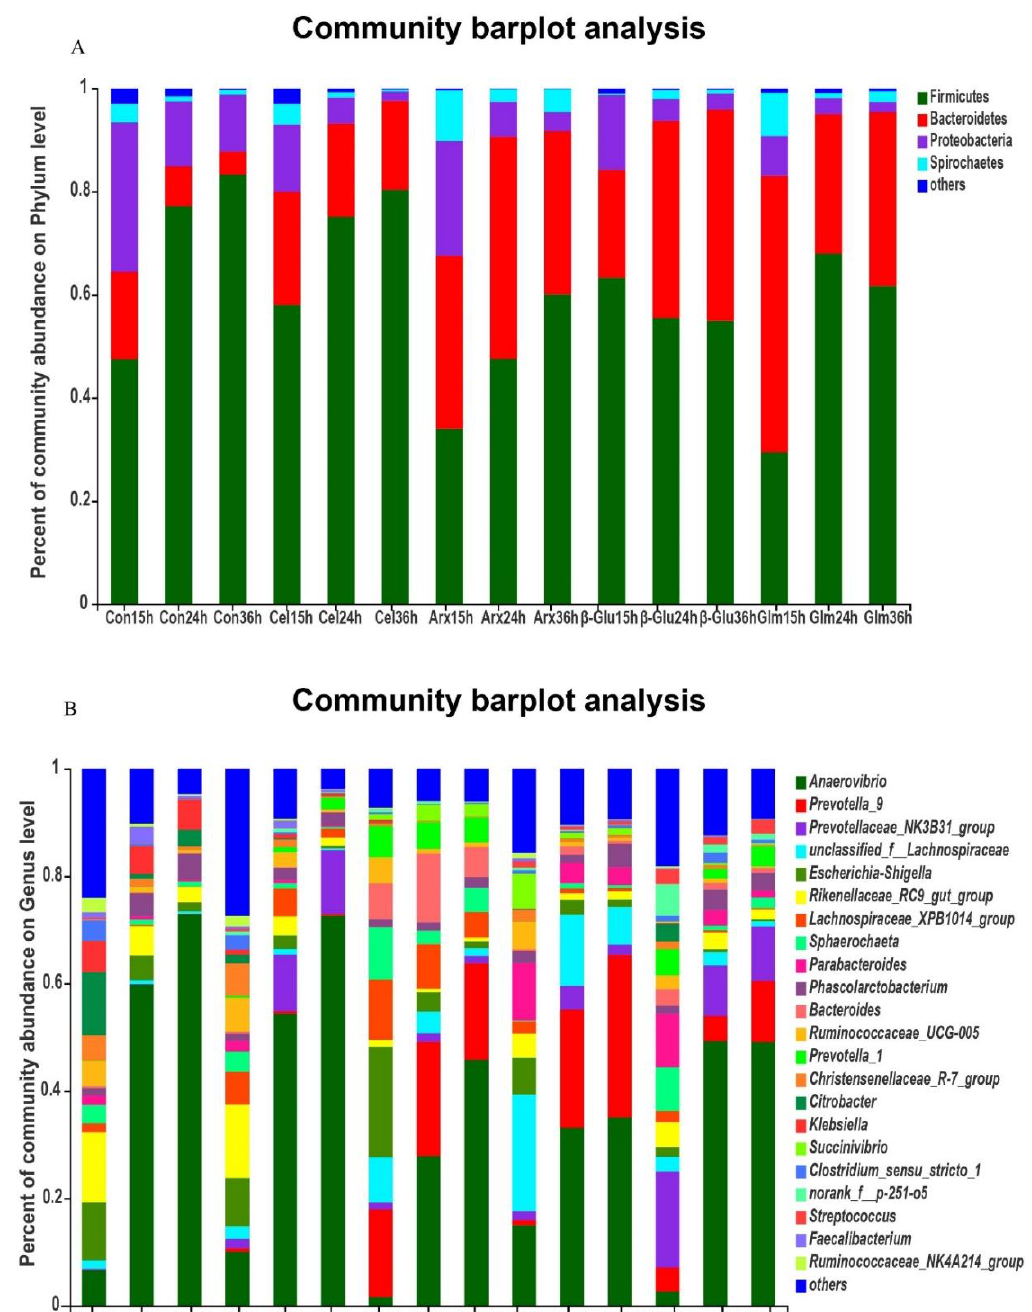
Figure 3. The microbial composition at the phylum and genus level in fermentation broth at 15, 24 and 36 h. The microbial community at the phylum level with an abundance greater than 0.01% in fermentation broth ( A ). The microbial composition at the genus level with an abundance greater than 1% in fermentation broth ( B ). ( n = 3; Con, control; Cel, cellulose; Arx, arabinoxylan; β − Glu, β − glucan; Glu, glucomannan).